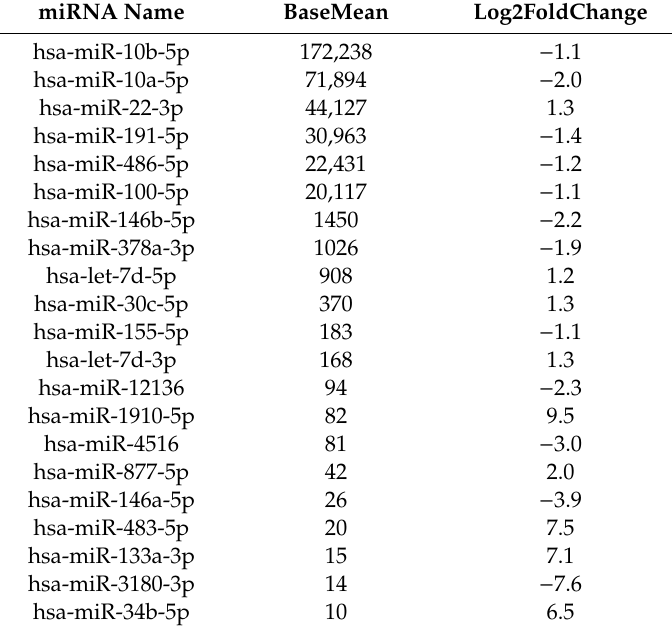
Table 2. miRNAswithdifferentialexpressionuponosteoblastogenicdifferentiation(D7vs.D0)inBMSC-EVs.